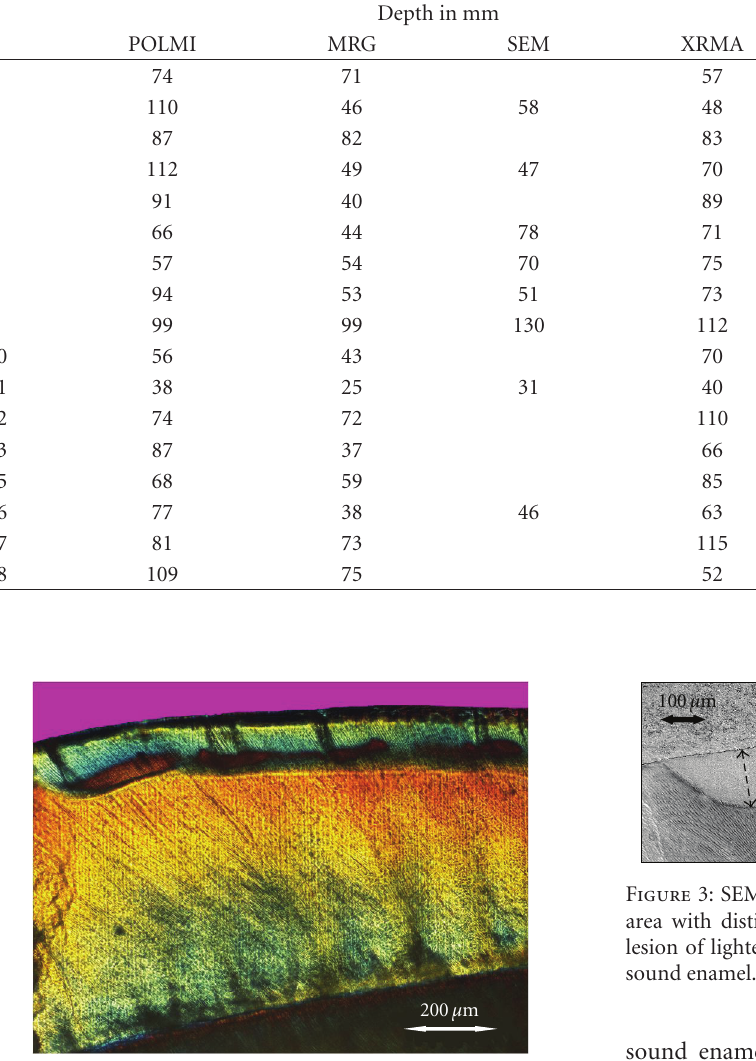
Figure 2: POLMI image, at 4x. The lesion is seen as a uniform demineralized zone, with a positive birefringent bulk below a negatively birefringent surface layer. At the lesion front, a zone with a higher degree of demineralization is seen.